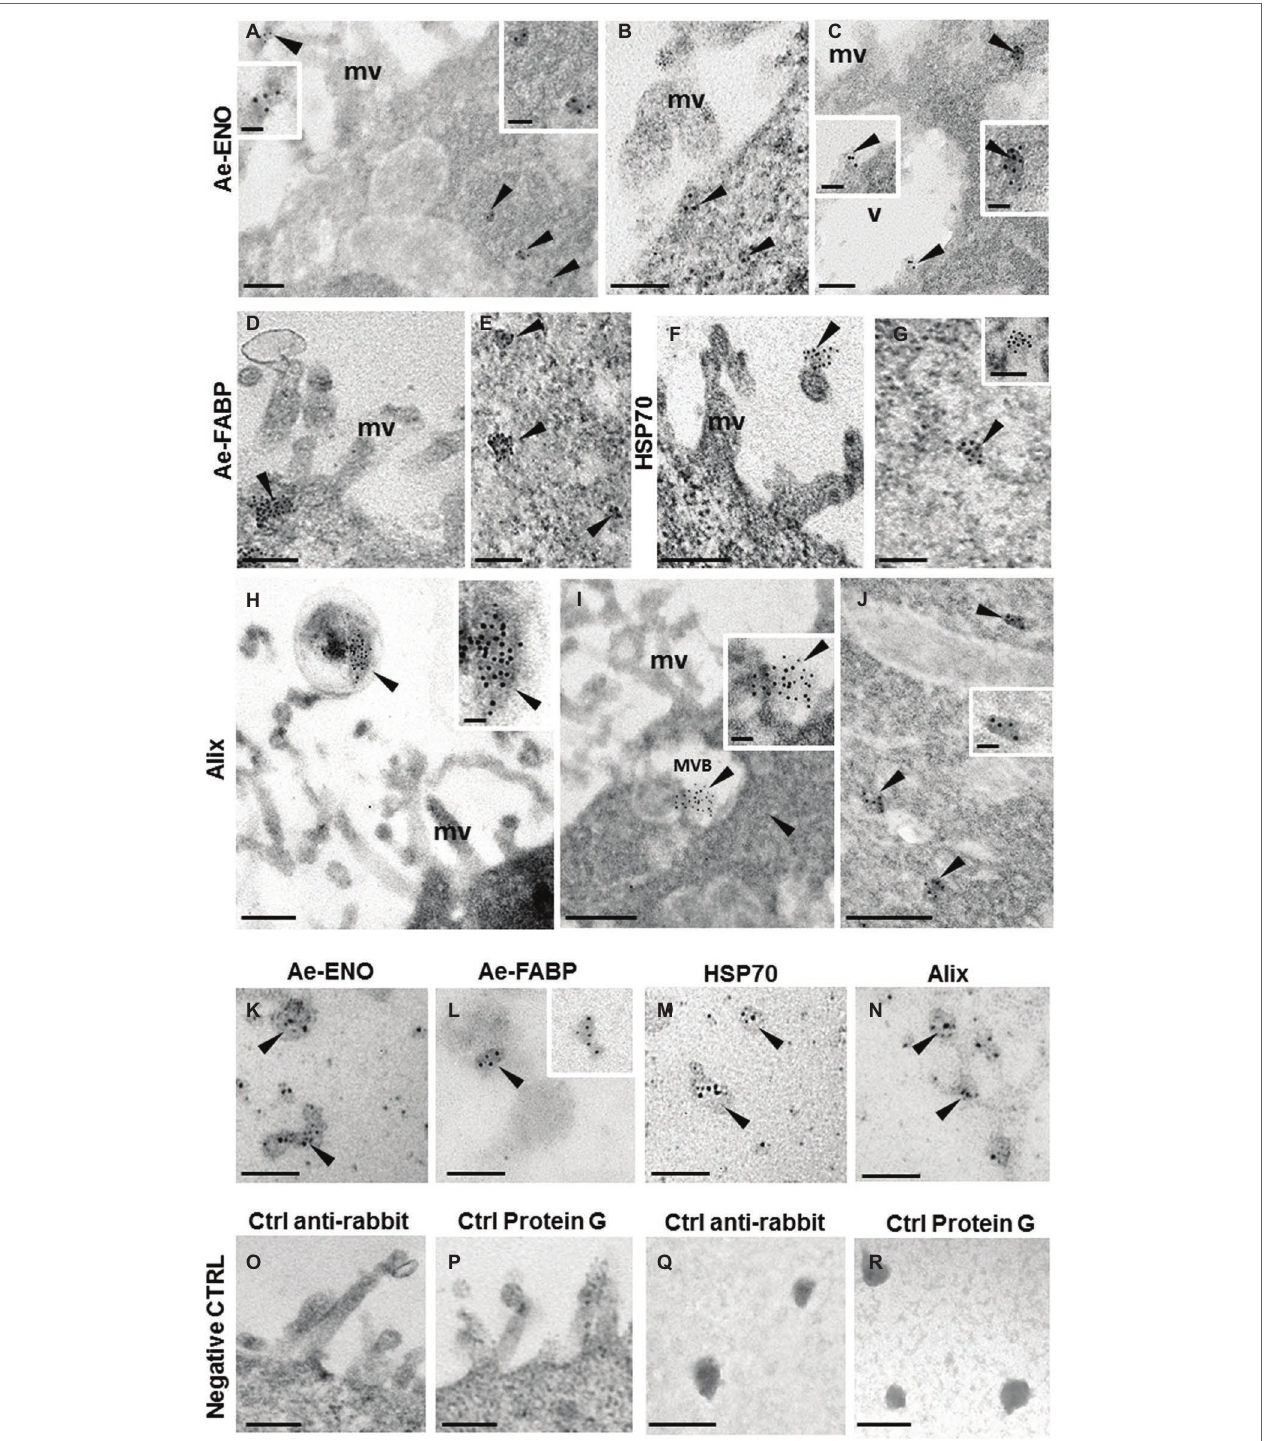
FIGURE 4 | Immunogold staining at TEM of Ae -ENO, Ae -FABP HSP70, and Alix. Gold nanoparticles (arrowheads) are visible in exosome-like vesicles released from teratocyte microvilli (A,F,H) underneath the plasma membrane (B–D) , in the multivesicular body located next to the plasma membrane (I) and in those dispersed in the cytoplasm (A,C,E,G,J) . Immunostaining assays performed on exosome-like structures released by teratocytes stimulated for 30 ′ with ATP 5 mM (K–N) . No signal was detected in control experiments, where the primary antibodies were omitted, and samples were incubated only with the anti-rabbit secondary antibody (O,Q) or with the protein G gold-conjugated (P,R) . (mv) microvilli; (MVB) multivesicular body; (v) vacuole. Bars in (A–G) and in (K–R) : 100 nm; bars in (H–J) : 200 nm; bars in inserts 40